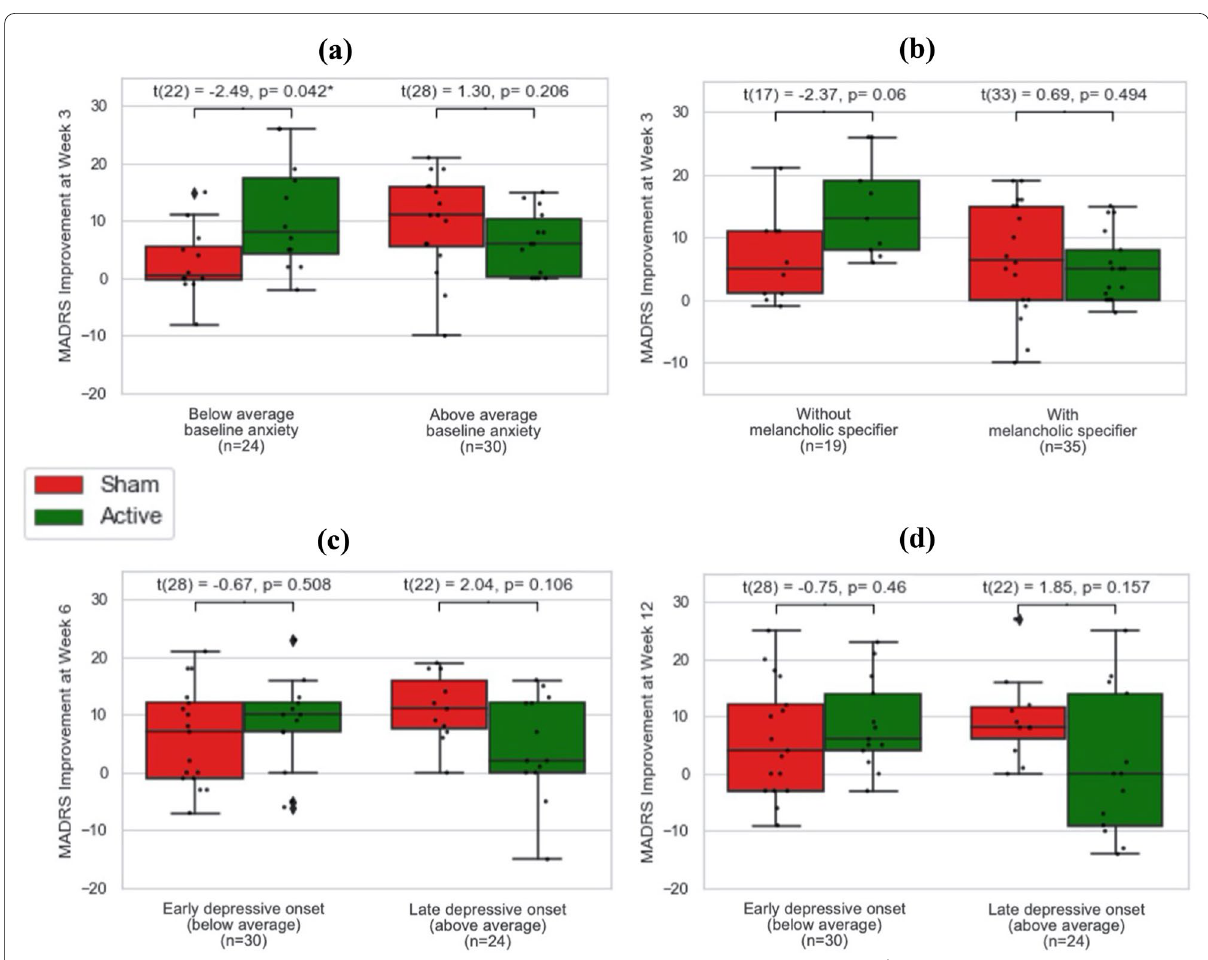
Fig. 2 Variables interacting with MADRS improvements in intention-to-treat analysis. MADRS, Montgomery–Åsberg Depression Rating Scale; *p < 0.05. a Baseline anxiety * treatment group interaction at week 3: β interaction at week 3: β Onset * group interaction at week 12: β